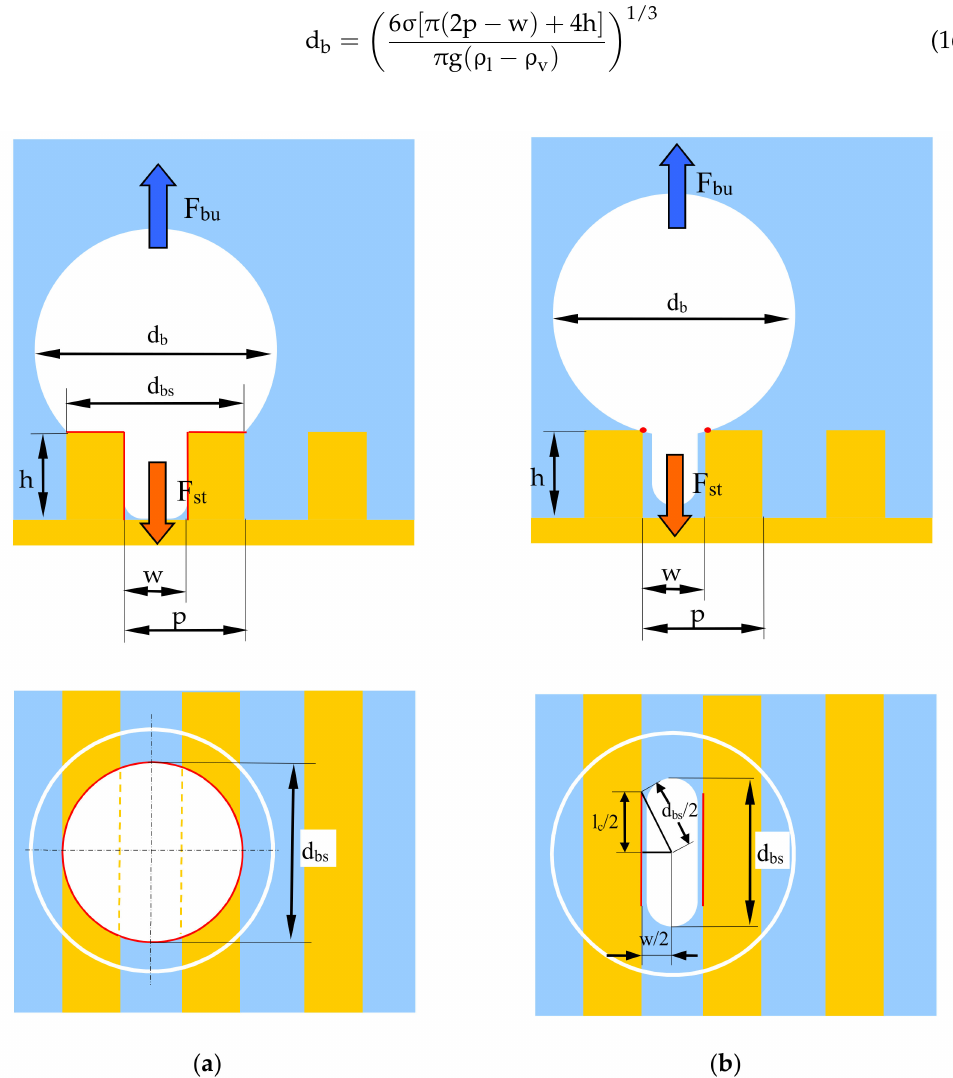
Figure 15. Two methods of determining the contact line: ( a ) Method I: contact with microfin tips, lateral surface, and the bottom of the microchannel, ( b ) Method II: contact with the microfin edge; the contact lines are marked in